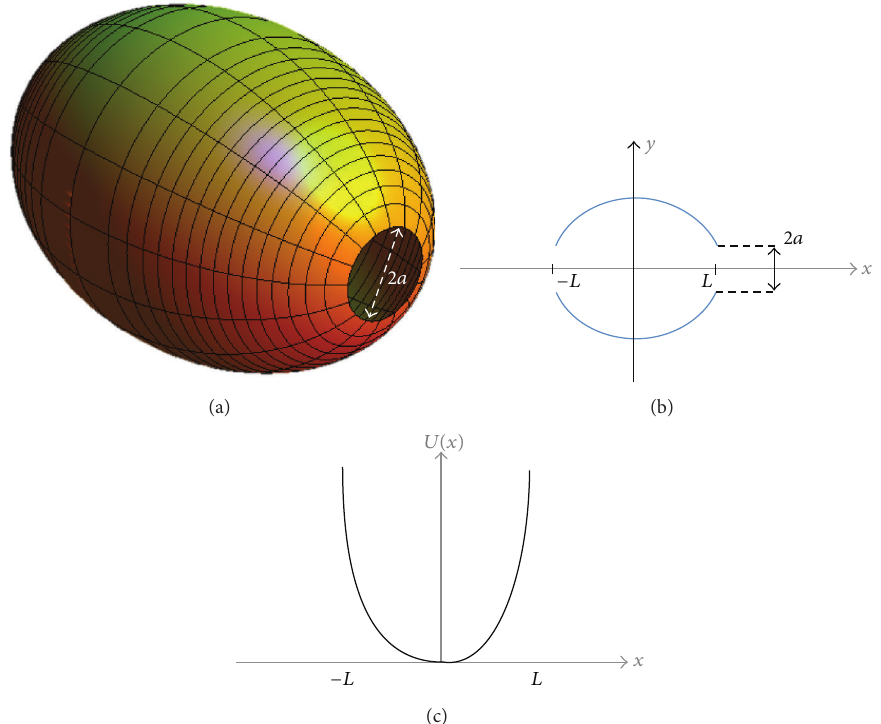
Figure 1: Elliptic tube. (a) A tube of circular cross-section where the position-dependent radius is given by 𝑟(𝑥) = ( 1 −𝜀 2 )√𝛾 2 − 𝑥 2 , an ellipse in the longitudinal plane, as shown in (b), where 𝛾 2 = 𝑅 2 /( 1 − 𝜀 2 ) is the square of its major radius. 𝑅 is the size of the minor radius of the elliptic shape; the tube’s length is 2 𝐿 , where 𝐿 = 𝑅√( 1 − (𝑎/𝑅) 2 )/( 1 − 𝜀 2 ) . The radius of the openings, at opposing sides of the tube, is 𝑎 , else 𝑎 2 = 𝜉 2 (𝛾 2 − 𝐿 2 ) , where 𝜉 2 = 1 − 𝜀 2 . Panel (c) shows a representation of the entropic-like potential associated with the change of shape in this